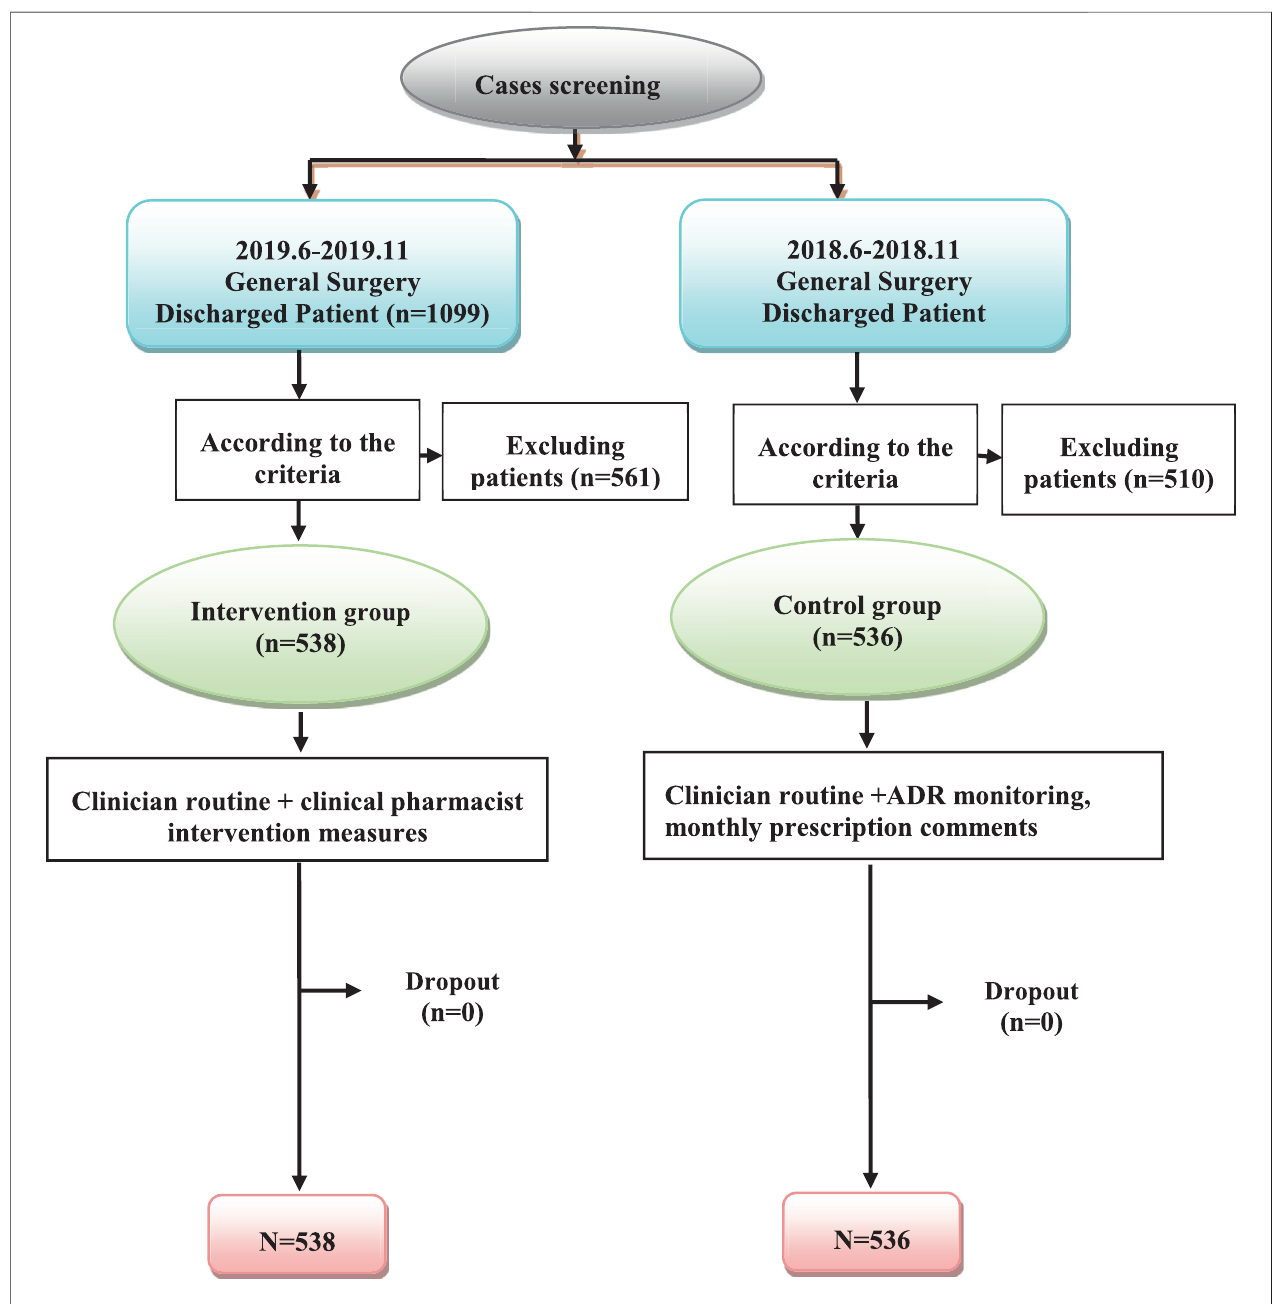
FIGURE 1 | Flow chart of case